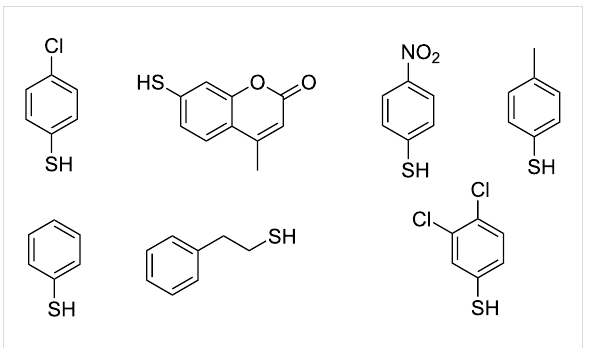
Figure 3: Examples of thiol-containing acceptors used in the chemo- enzymatic biosynthesis of S -glycosides catalysed by S